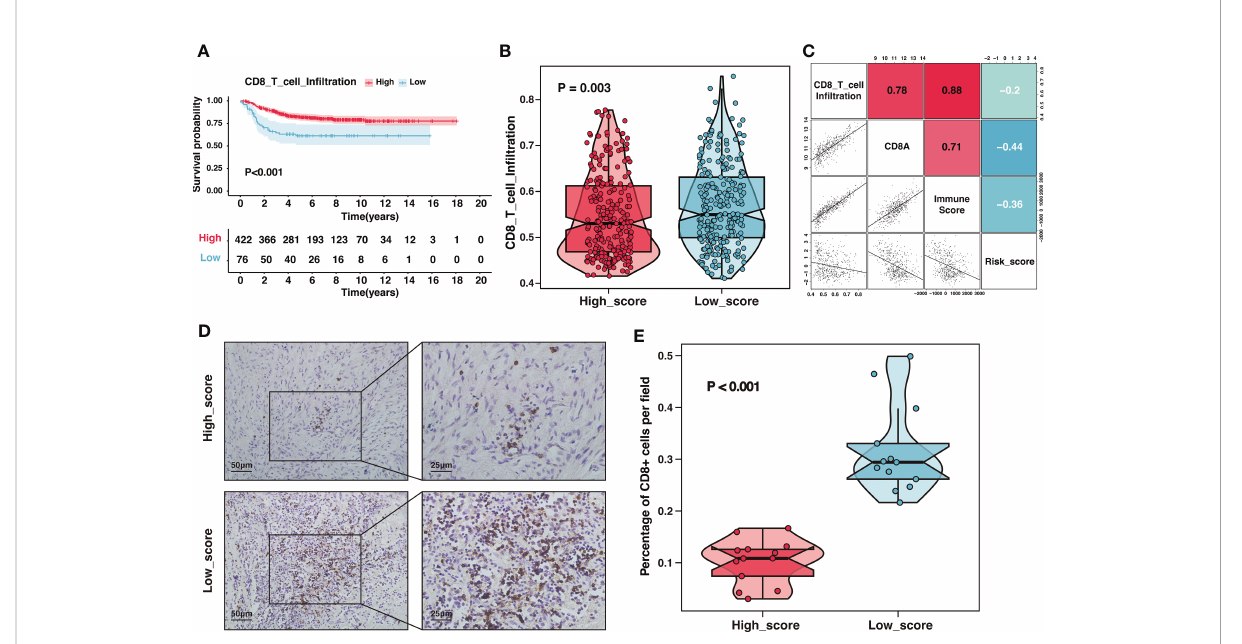
FIGURE 9 The high-score group presented low CD8 + T-cell in fi ltration. (A) Kaplan – Meier curves of overall survival between samples with different in fi ltration of CD8 + T-cell in the GSE49710 dataset. (B) The comparison of CD8 + T-cell in fi ltration between high-score and low-score groups in the GSE49710 dataset. (C) The correlation analysis of the risk score, CD8 + T-cell in fi ltration, CD8A expression and immune-score in the GSE49710 dataset. (D) Representative immunohistochemistry (IHC) images showing the in fi ltration of CD8 + T-cell between different risk groups in Tianjin cohort. Magni fi cation, ×200, ×400. (E) The comparison of CD8 + T-cell in fi ltration between different risk groups in Tianjin